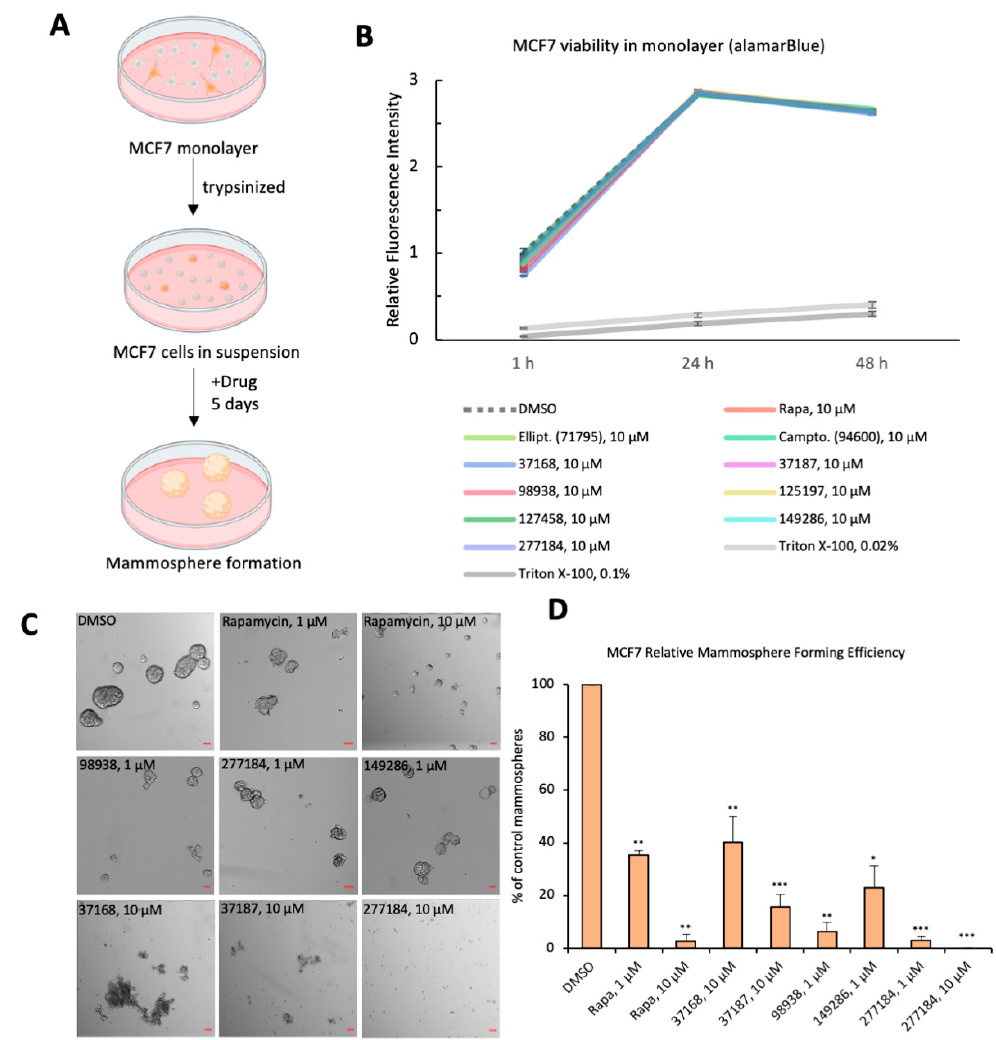
Figure 3. Tertiary screen for CSC impairment in MCF7 breast cancer organoids ( A ) Schematic representation of the experimental procedure for MCF7 organoid formation and candidate drug treatment for various concentrations. ( B ) alamarBlue cell viability curve for MCF7 cells in monolayer treated with either vehicle (DMSO), small molecules, or Triton X-100. Relative fluorescence intensity was computed as ((absorbance[condition] − absorbance[blank])/(absorbance[DMSO, 1 h]). ( C ) Brightfield images of MCF7-derived mammospheres after being treated with the indicated each small molecule drug candidates or vehicle (DMSO) and their specified concentration (Scale bar 100 µm). ( D ) Quantification of mammospheres >250 µm in diameter. Relative mammosphere formation efficiency (MFE) is computed as a percentage of control (no. of mammospheres [condition]/no. of mammospheres [DMSO] ∗ 100%). Significance is calculated by Student’s t -test between control (DMSO) and each drug treated condition, ) * p ≤ 0.05, ** p ≤ 0.01, *** p ≤ 0.001.